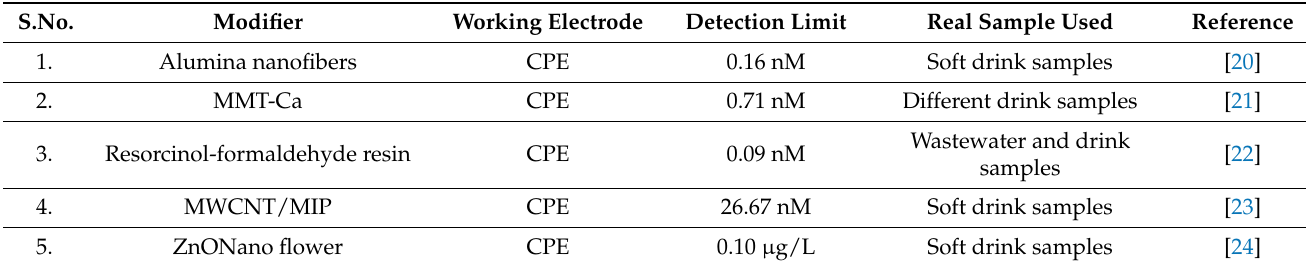
Table 2. Table showing Sunset Yellow detection using carbon paste electrodes with different modifiers along with their detection limits.